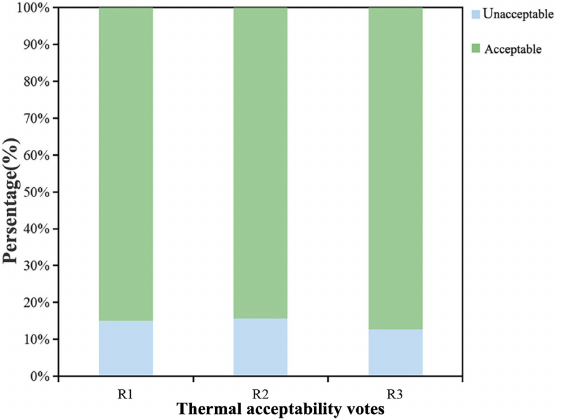
Figure 8. Thermal Acceptability Vote (TAV) in three different measuring